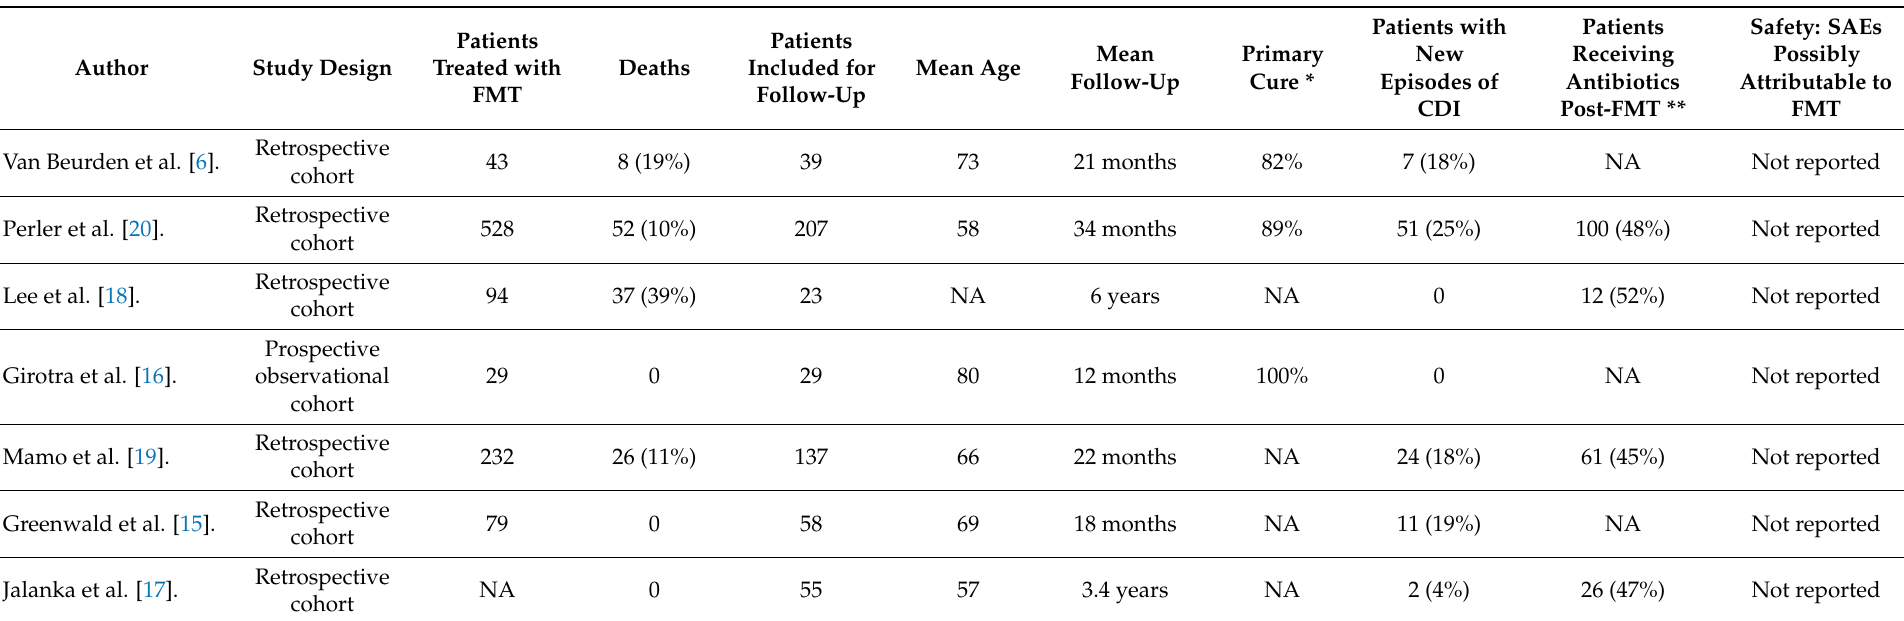
Table 3. Studies reporting on long-term follow-up after